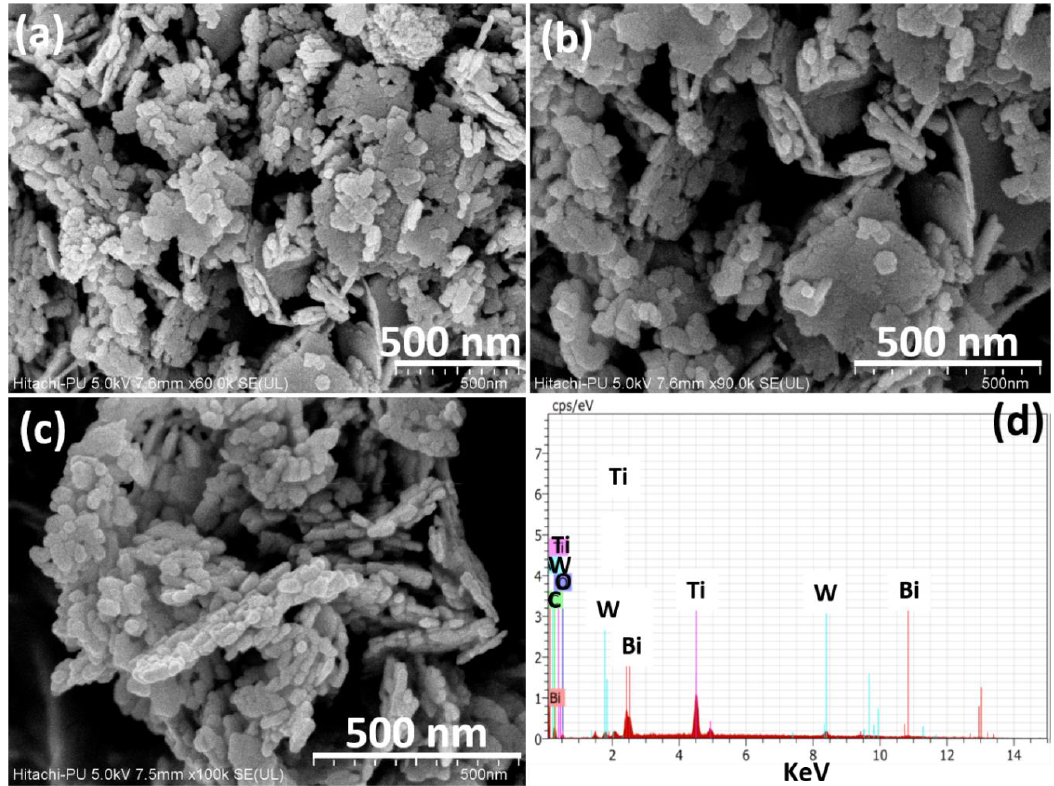
Figure 2. ( a – c ) FESEM images of Bi 2 WO 6 / C-dots / TiO 2 at di ff erent magnifications. ( d ) EDX of Figure 2. ( a,b,c ) FESEM images of Bi 2 WO 6 /C-dots/TiO 2 at different magnifications. ( d ) EDX of Bi 2 WO 6 / C-dots / TiO 2. Bi 2 WO 6 /C-dots/TiO 2.